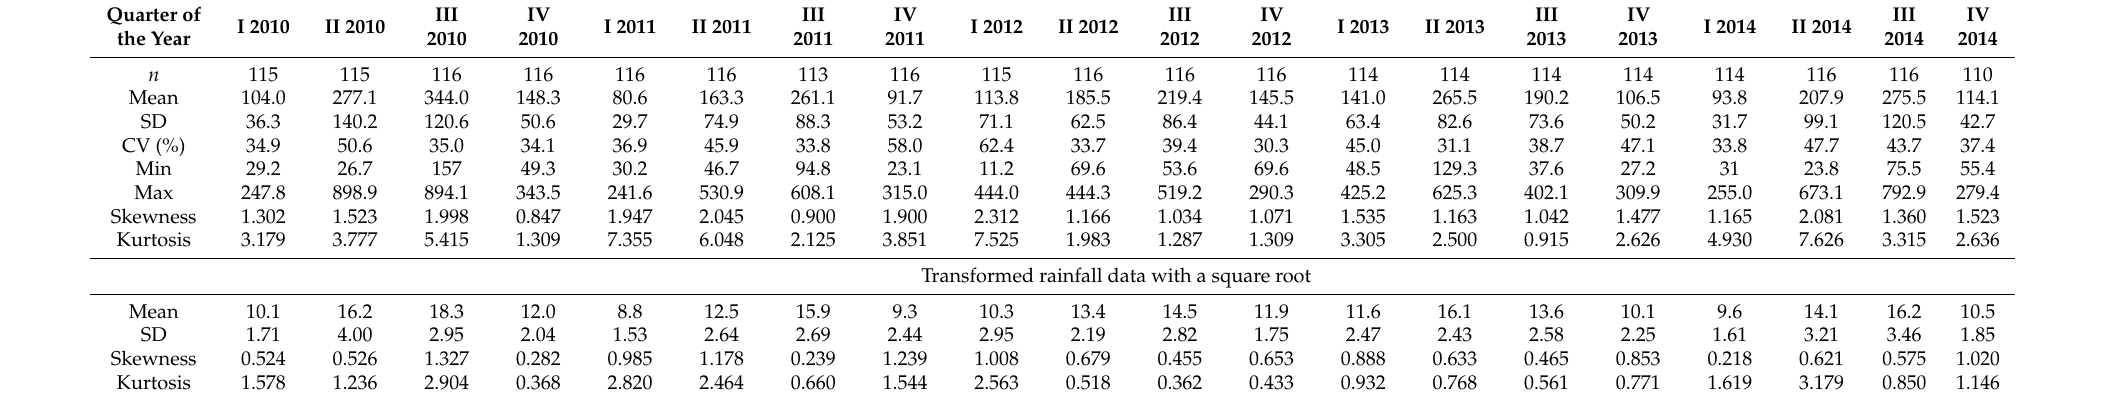
Table 1. Summary statistics for quarterly rainfall data of Poland and neighbouring